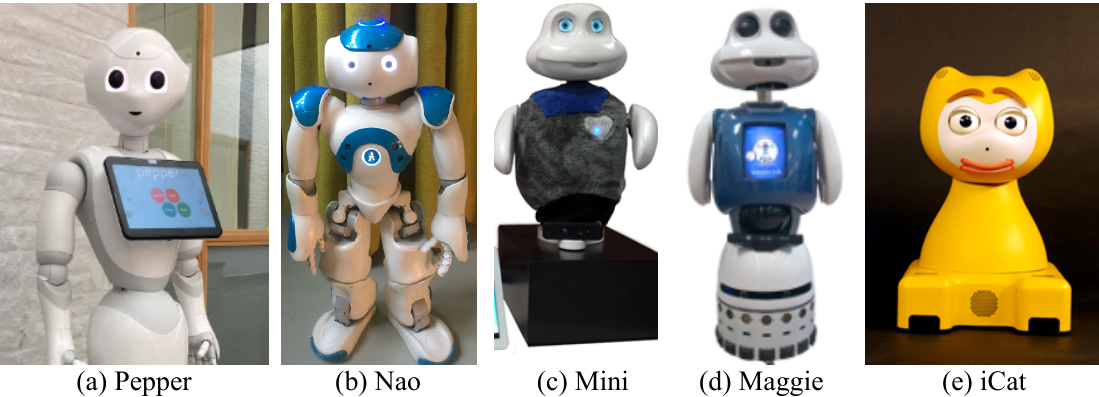
Figure 1. Some of the social robots platforms referenced within the reviewed papers. (The pictures of ( a ) Pepper robot, and ( b ) Nao robot were taken by the authors. ( c ) Mini robot, the figure is adapted from [13]—licensed under the Creative Commons Attribution, ( d ) Maggie robot, the figure is from https://robots.ros.org/maggie/, accessed on 20 March